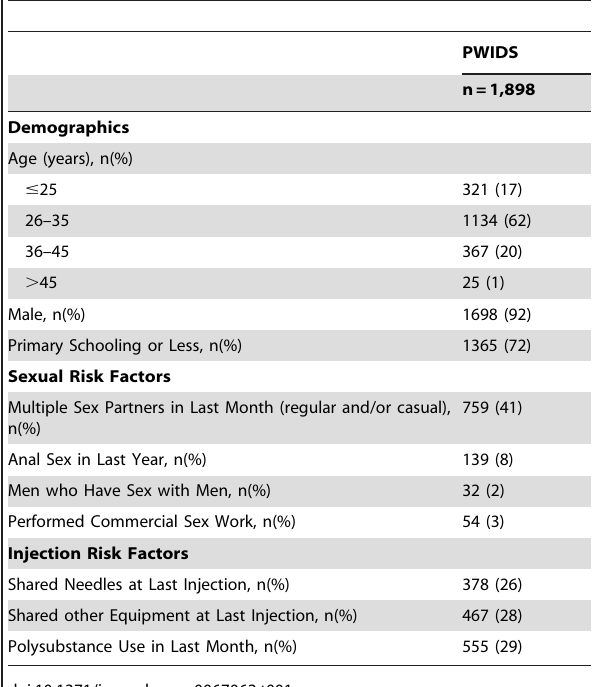
Table 1. Demographics and Risk Factors of People who Inject Drugs Contacted by Outreach